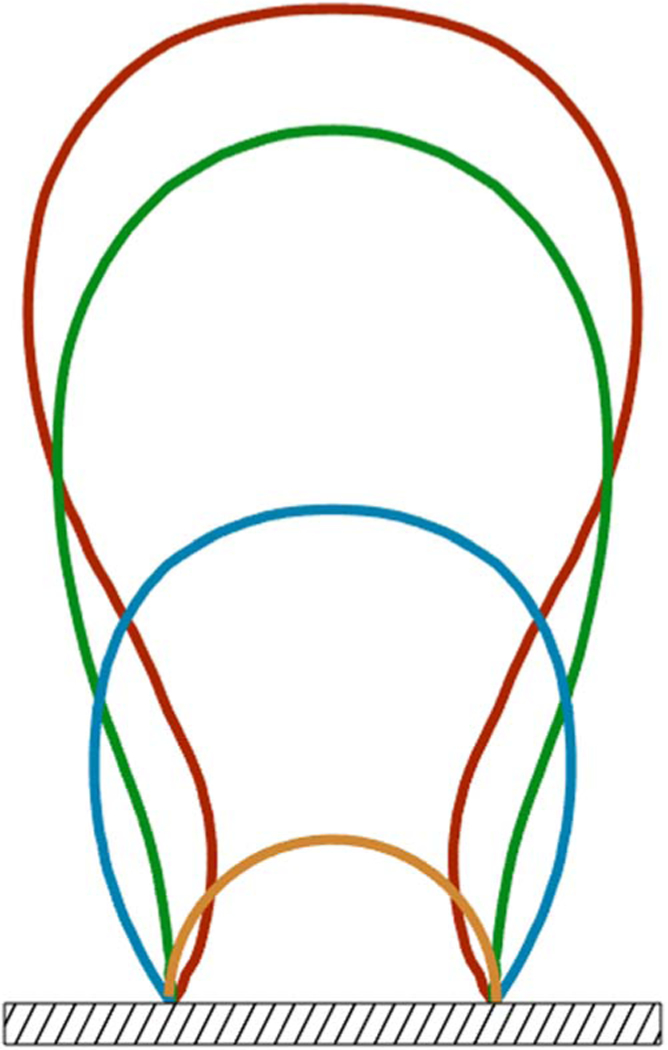
A sketch of the stages of bubble growth before detachment from a substrate: nuclei (orange line), under critical growth (blue line), critical growth (green line), and necking (red line).